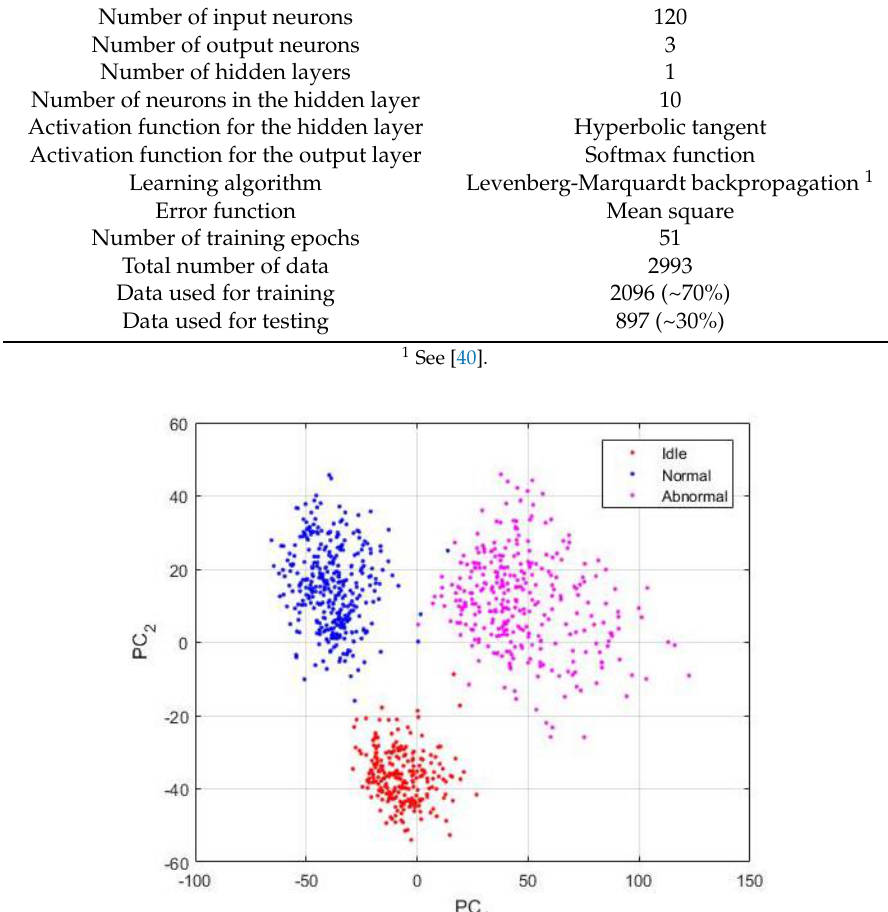
Table 2. Details of the classification network.